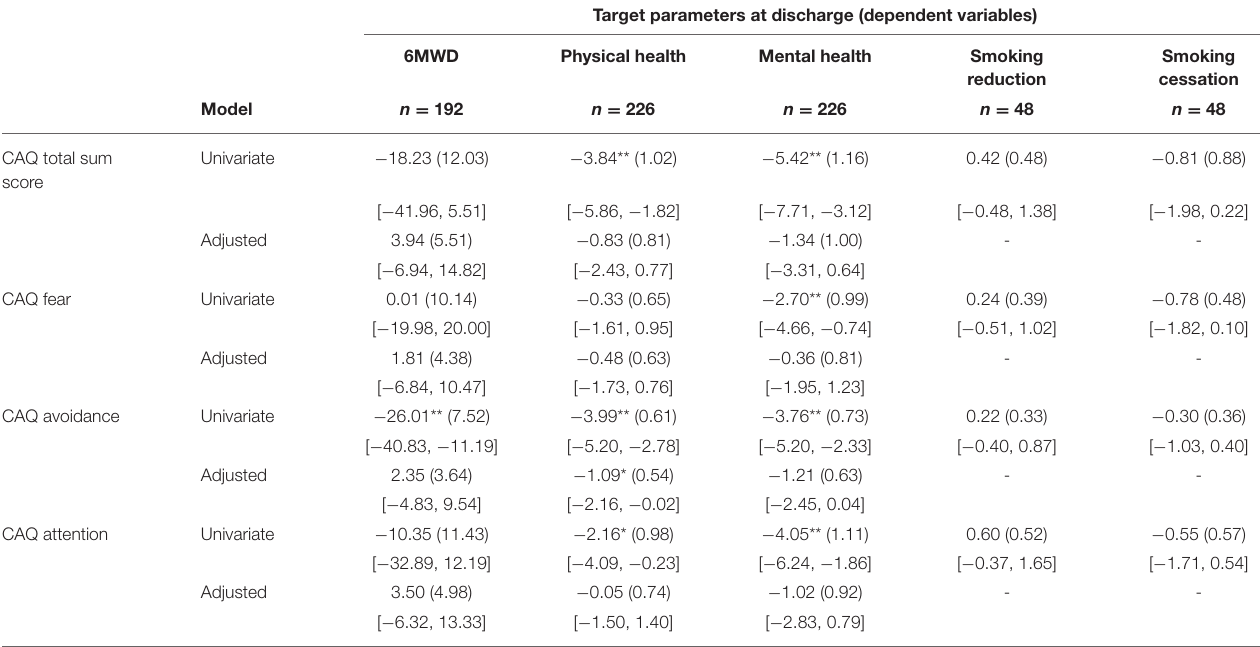
TABLE 4 | Regression coefficients of the baseline CAQ scales predicting outcome parameters at discharge in separate regression